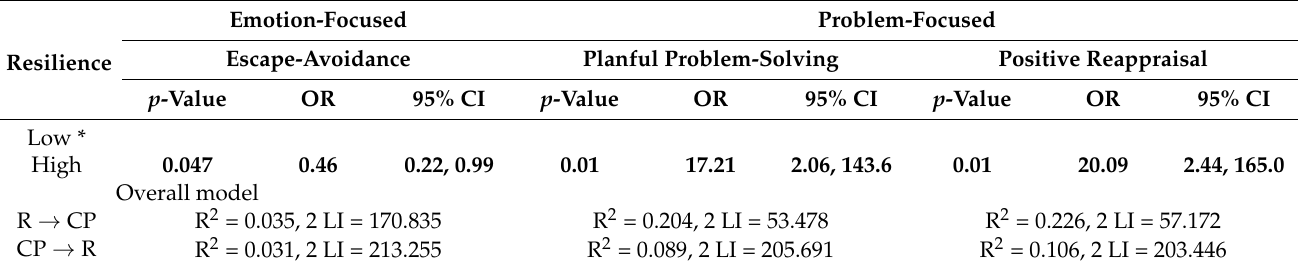
Table 6. Univariate association between individual resilience and coping strategies.